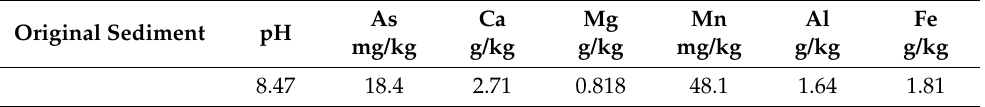
Table 1. Physico-chemical parameters of the